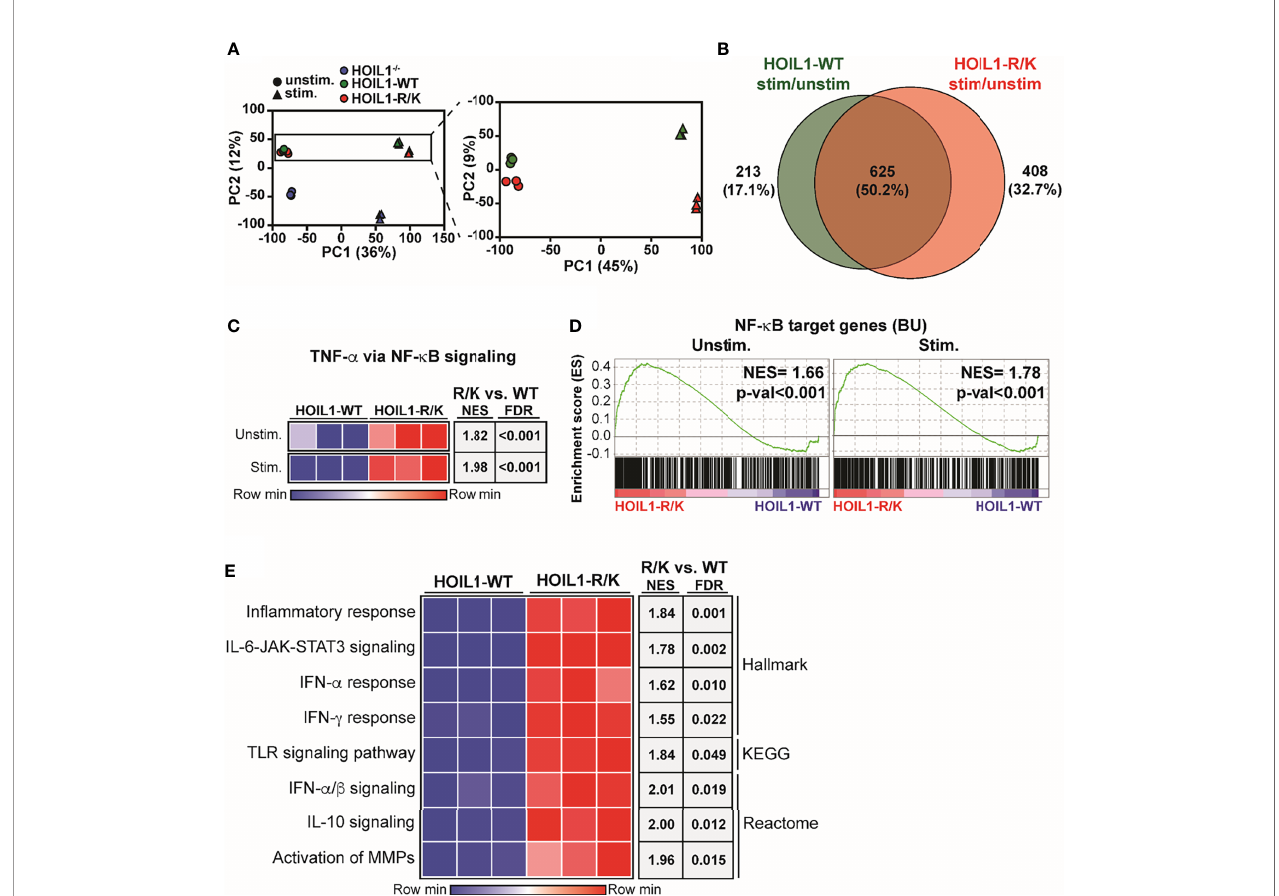
FIGURE 3 | Impact of non-cleavable HOIL1 on the transcriptome. (A) Principal component analysis (PCA) comparing unstimulated and stimulated (10 ng/mL IL-1 b for 4 h) HOIL1 – / – (blue), HOIL1-WT (green), HOIL1-R/K (red) fi broblasts. The contribution of PC1 or PC2 is shown in brackets. Triangles represent unstimulated and circles represent stimulated. Shown on the right is an inset of the HOIL1-WT and HOIL1-R/K region. (B) Venn diagram comparing number of genes that were signi fi cantly upregulated (adjusted p-val ≤ 0.05, fold change ≥ 1) in response to stimulation between HOIL1-WT and HOIL1-R/K. (C) Sample level enrichment analysis (SLEA) representation of the TNF- a via NF- k B signaling pathway (MSigDB Hallmark) in HOIL1-WT or HOIL1-R/K fi broblasts pre- and post-stimulation. The data in the heatmaps was scaled by the sum of each row. Shown on the right are normalized enrichment scores (NES) and false discovery rate (FDR) q-values of HOIL1-R/K vs. HOIL1-WT. (D) Gene set enrichment analysis plots of NF- k B target genes (The Gilmore Lab, Boston University [BU]) pre- or post-stimulation between HOIL1-R/K and HOIL1-WT. NES = normalized enrichment score. (E) SLEA representation of various major proin fl ammatory pathways. Shown on the right are NES and FDR q-val of stimulated HOIL1-R/K vs. stimulated